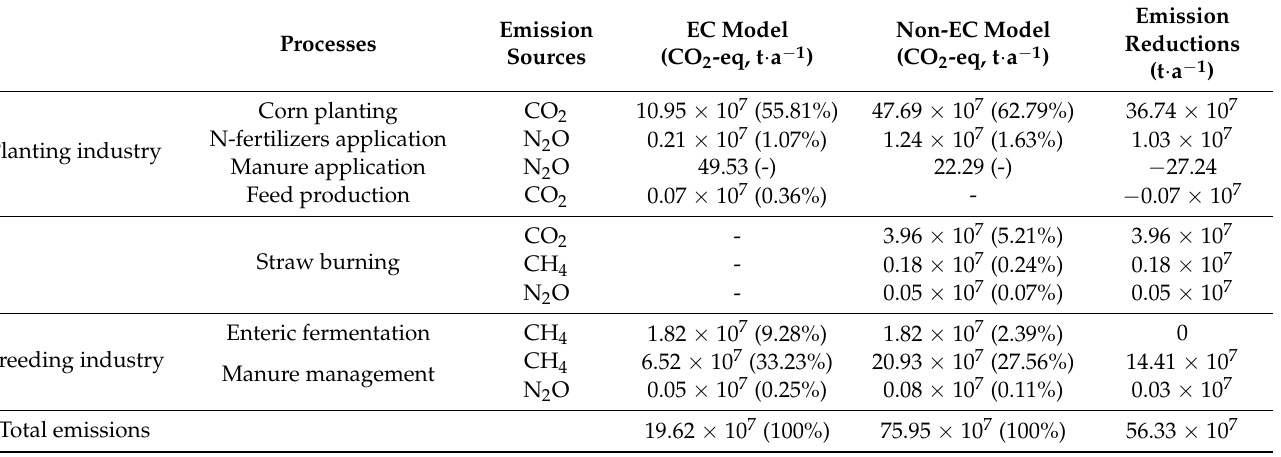
Table 2. GHG emissions and proportions of each